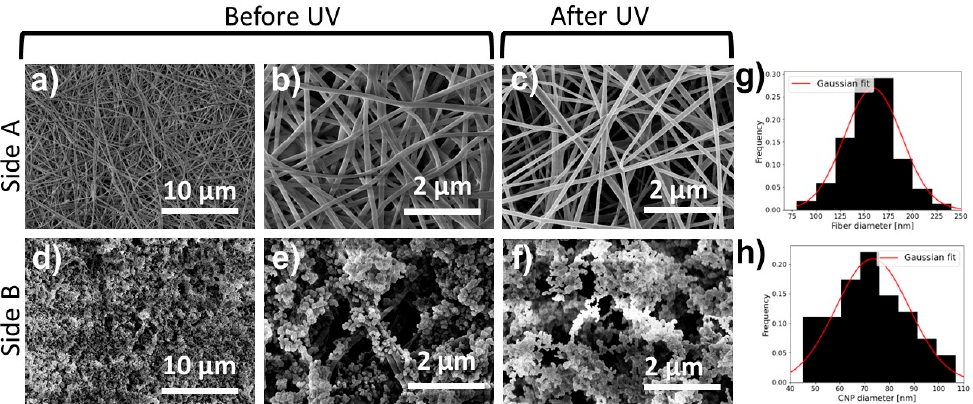
Figure 4. FE-SEM images of the PVA-CNP Janus membrane on Side A ( a , b ) and Side B ( d , e ) and of the PVA-CNP membrane after UV irradiation on Side A ( c ) and Side B ( f ). Histograms of both the nanofibers ( g ) and the CNPs ( h ) diameter distribution are shown on the right.